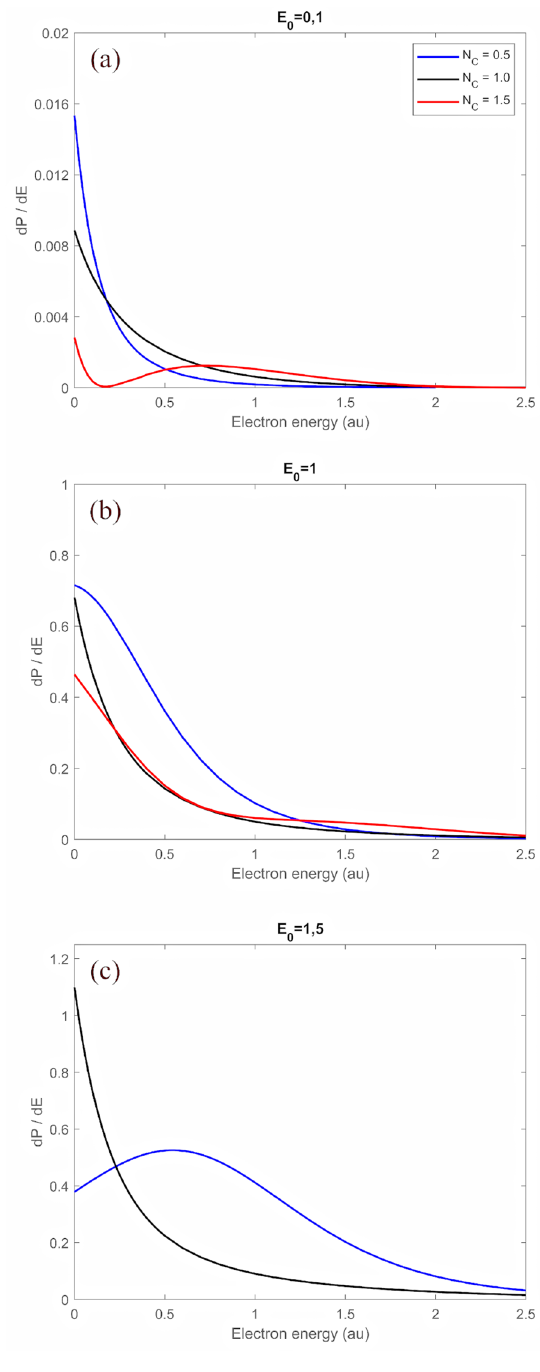
Figure 5. Ionization spectra of H for different numbers of half cycles N c and different field amplitudes E 0 . ( a ): E 0.1 , ( b ): E 0 1.0 , ( c ): E 0 1.5 . Please note, the diagrams contain different scalings of dP / dE 0 = = =